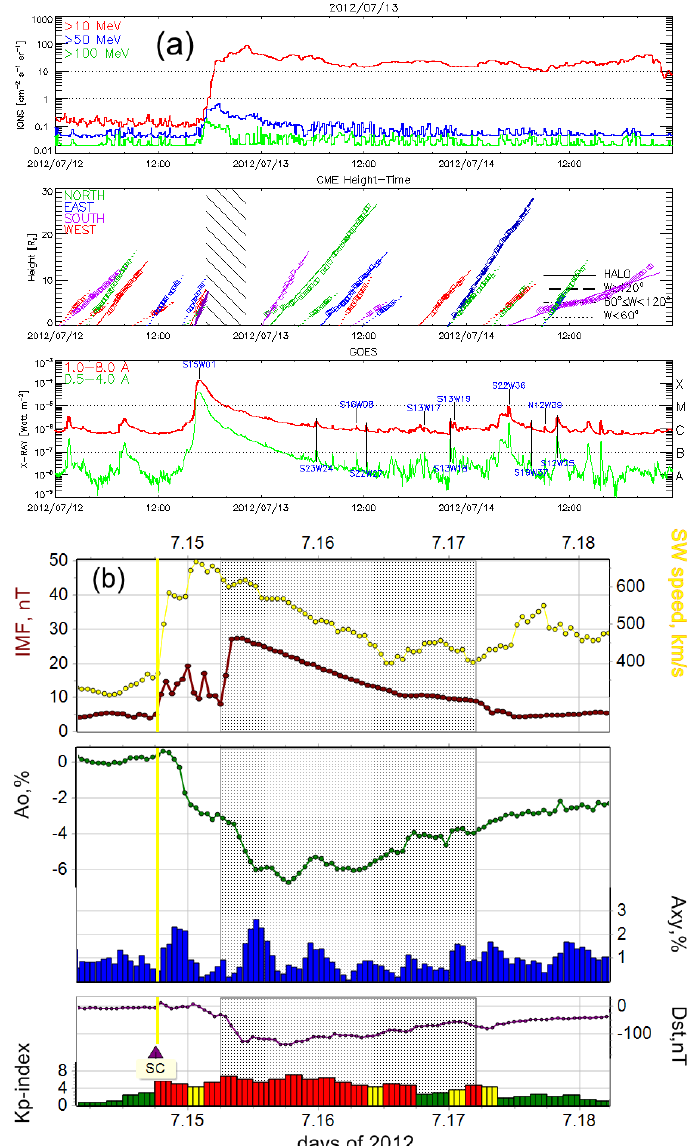
Figure 5. An example of an event from the P 10 group: ( a ) PHTX (taken from SOHO/LASCO CME Catalog); ( b ) behavior of the main SW, IMF, CR, and GA parameters during the FD on 14–17 July